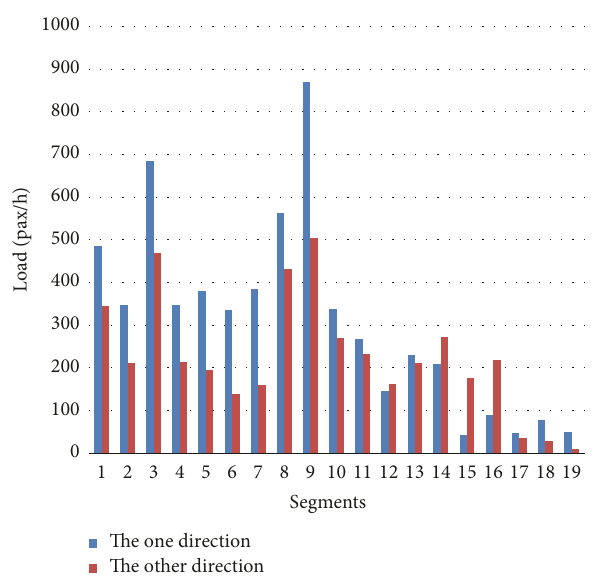
Figure 6: Optimal schemes with control